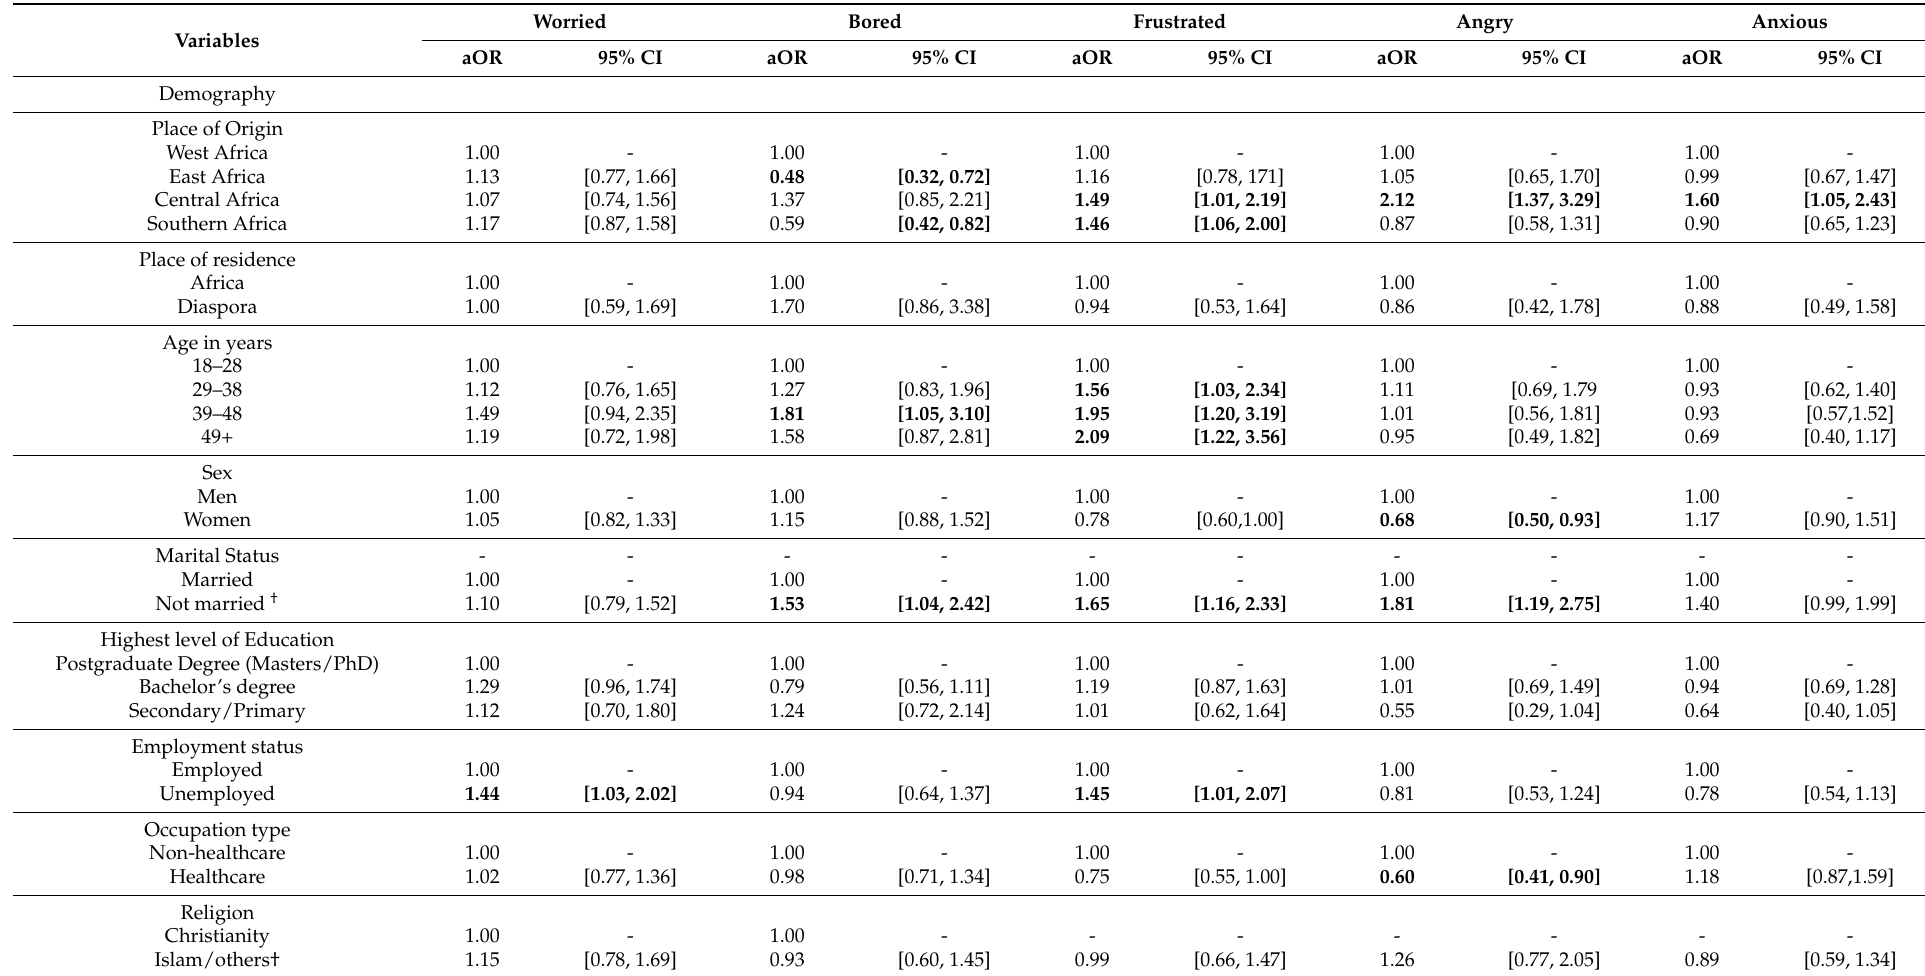
Table 3. Multivariate analysis of factors associated with mental health/emotional impact of COVID-19 among Sub-Sahara Africans during the lockdown. Worried Bored Frustrated Angry Anxious Variables aOR